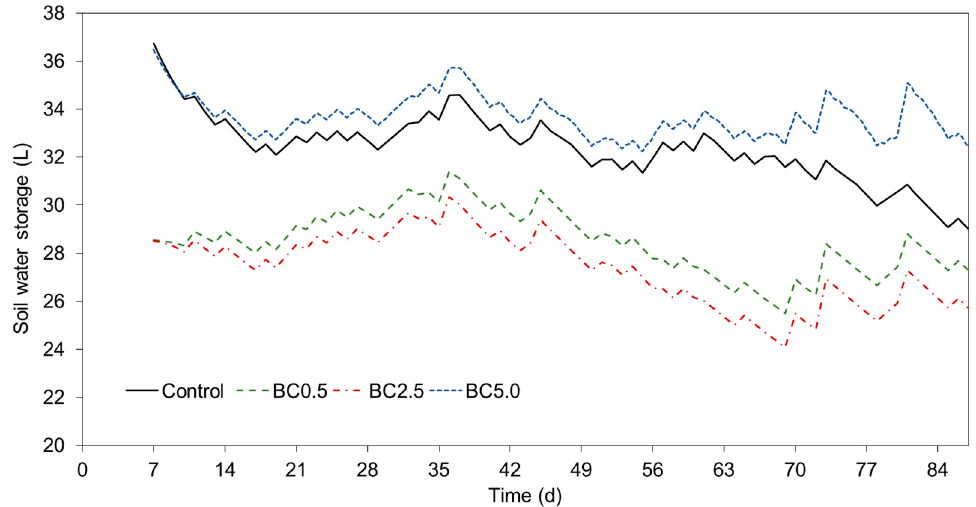
Figure 6. Changes in volume of soil water storage over time for the different treatments, estimated using HYDRUS 1D